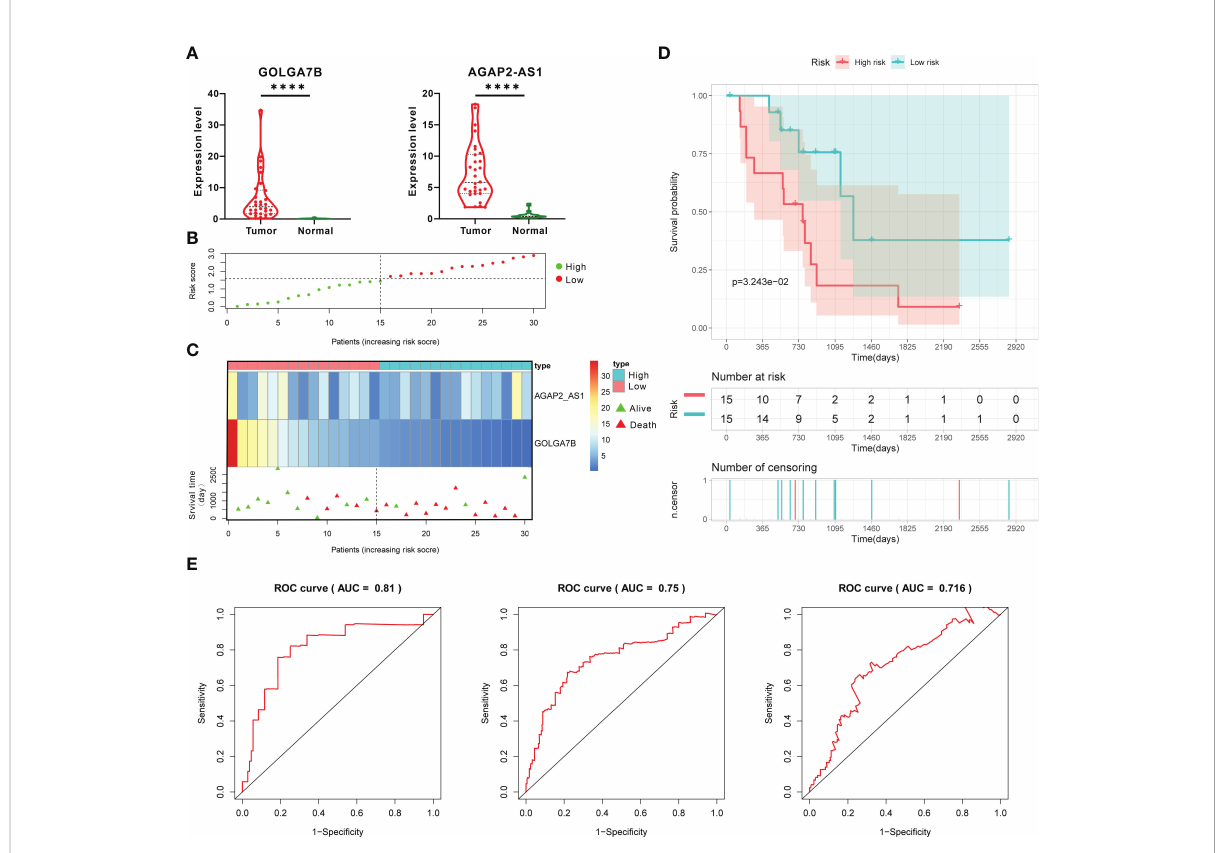
FIGURE 6 External validation of the prognostic gene signature in the testing group. (A) The RNA expression of GOLGA7B and AGAP2 − AS1 in tumor tissues was higher than that in normal tissues of CCA patients in the testing group. (B) The risk plot shows the RS of each CCA patient in the testing group. (C) The risk plot shows that CCA patients with higher RSs were associated with lower GOLGA7B expression and a better survival rate. (D) Kaplan – Meier curves con fi rmed that in the testing group, CCA patients in the high-risk group had a lower survival probability. (E) ROC curve and AUC values for validating the predictive competence of the two-gene prognostic prediction signature. **** P <0.0001.